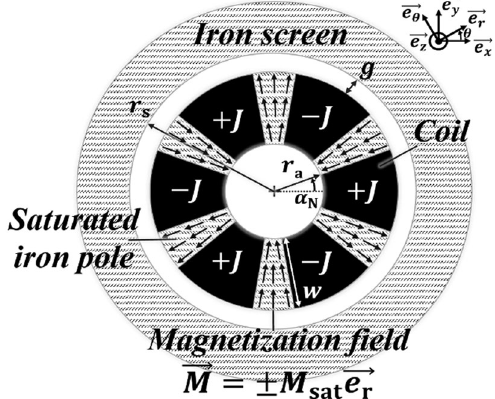
FIG. 2. Sketch of a 2 N -poles sector coil with iron screen, saturated iron poles and associated magnetization field for N ¼ 3 (i.e.,